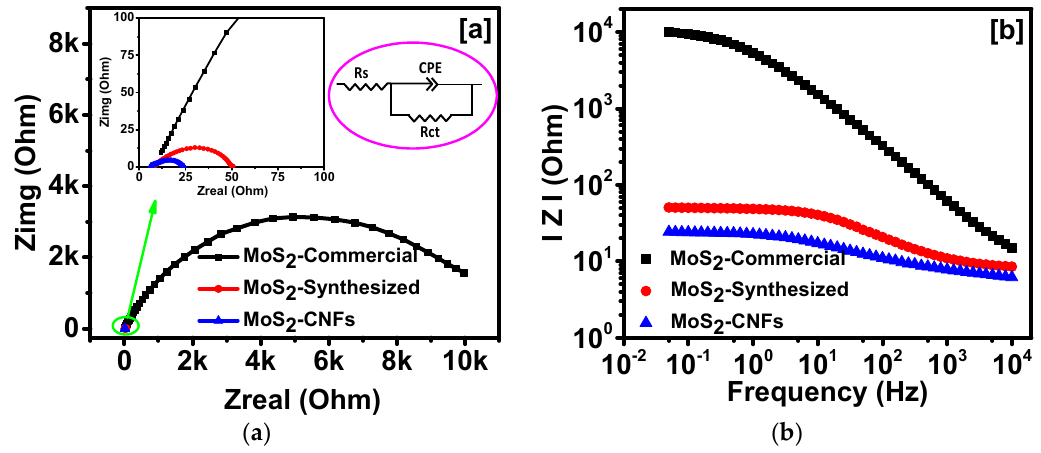
Figure 6. ( a ) Nyquist plot; inset figures show the zoomed Nyquist plot near origin (left) and equivalent circuit (right), and ( b ) variation of Z vs. frequency for various MoS 2 samples at 0.45 V vs. Ag/AgCl.